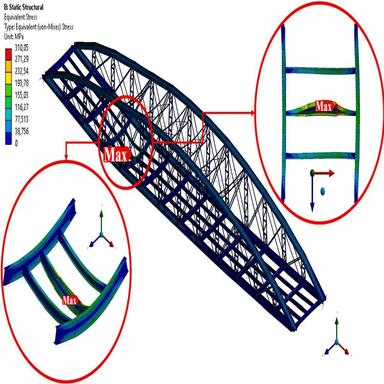
Detail of the bridge failure mechanism for the critical loading position.